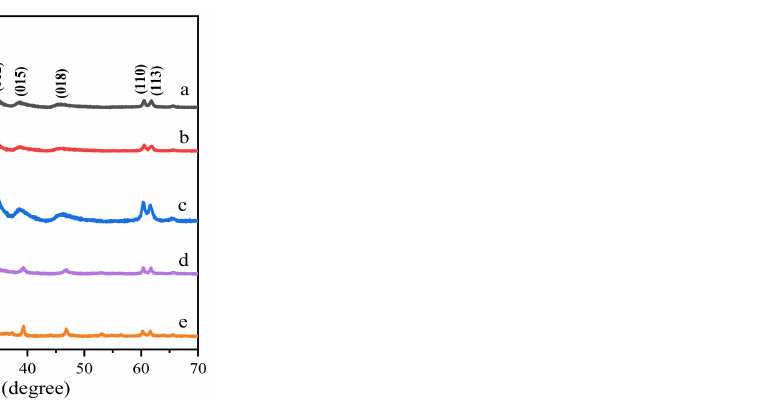
Figure 2. XRD spectra of Zn-Mg-Al HT supported gold nanoclusters: ( a ) Au 25 /MgAl-HT;